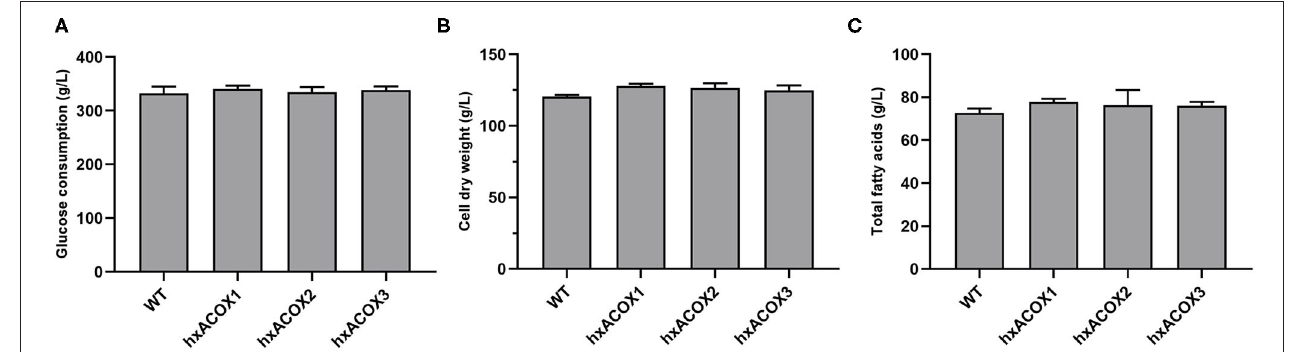
FIGURE 5 | Comparison of cell growth and the accumulation of lipids between the strain WT and the strains ACOX1-3 at 120h in 500-mL shake flasks. (A) Glucose consumption, (B) CDW, (C) Lipid productivity. Values and error bars represent the means and standard deviations from triplicate experiments.